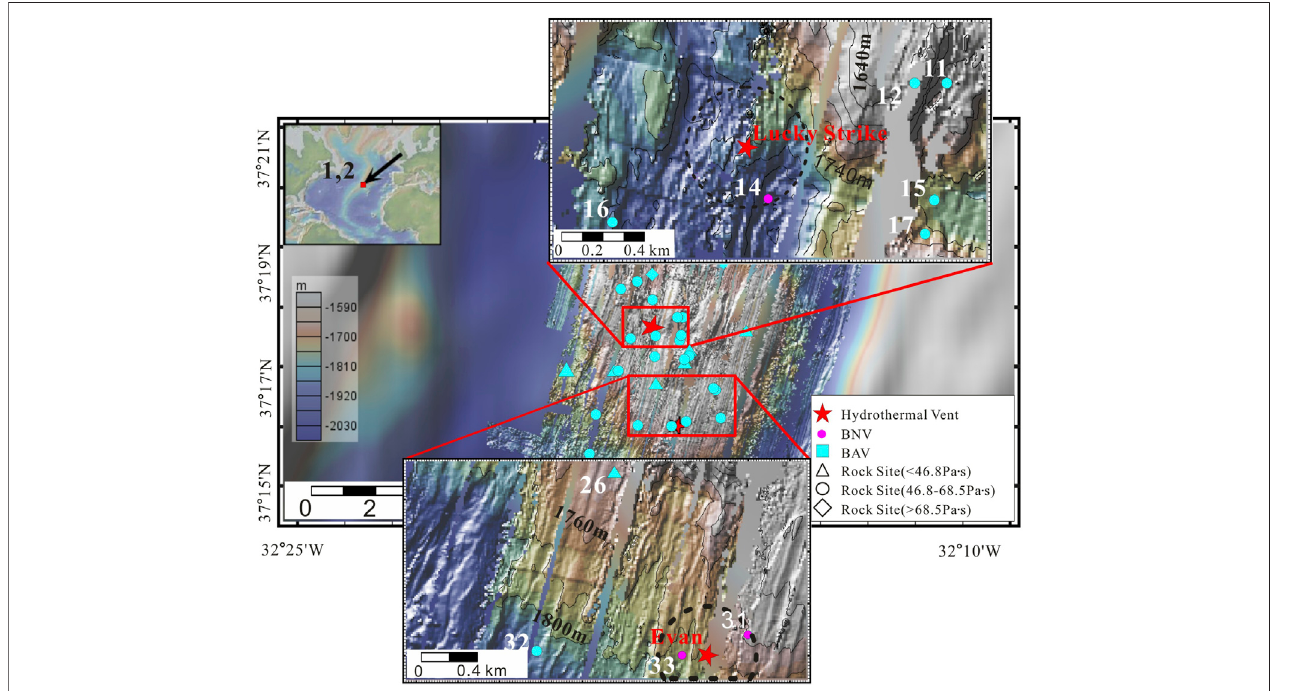
FIGURE5| BathymetricmapfromGeoMapApp,showingthelocationsoftheLuckyStrikevent,theEvanvent,andthesamplesites.Thecolorbarisnotapplicable to the two local maps. Black solid lines are the 20 m isobaths. The symbols and color bar are explained in the caption of Figure 3 .